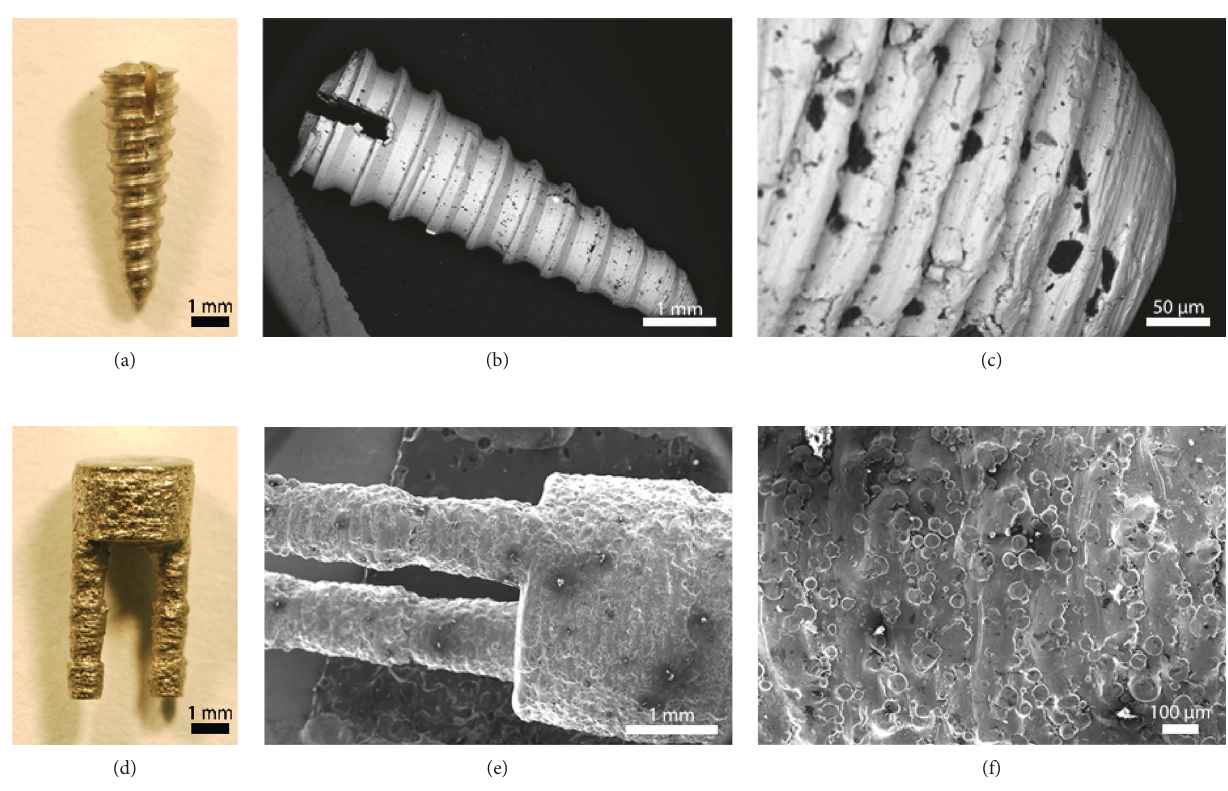
Figure 1: (a) Photo of control conical implant (Ø (cid:136) 2 mm, l (cid:136) 6mm). (b, c) SEM images of control surface. (d) Photo of dual-stemmed (SIT) implant (Ø (cid:136) 3mm, l (cid:136) 6mm). (e, f) SEM images of SIT implant surface. At higher magnification, it is clear that the 3D printed surface (f) retains characteristic surface features representative of the powders used in its production and has a much higher roughness than conventionally machined implants